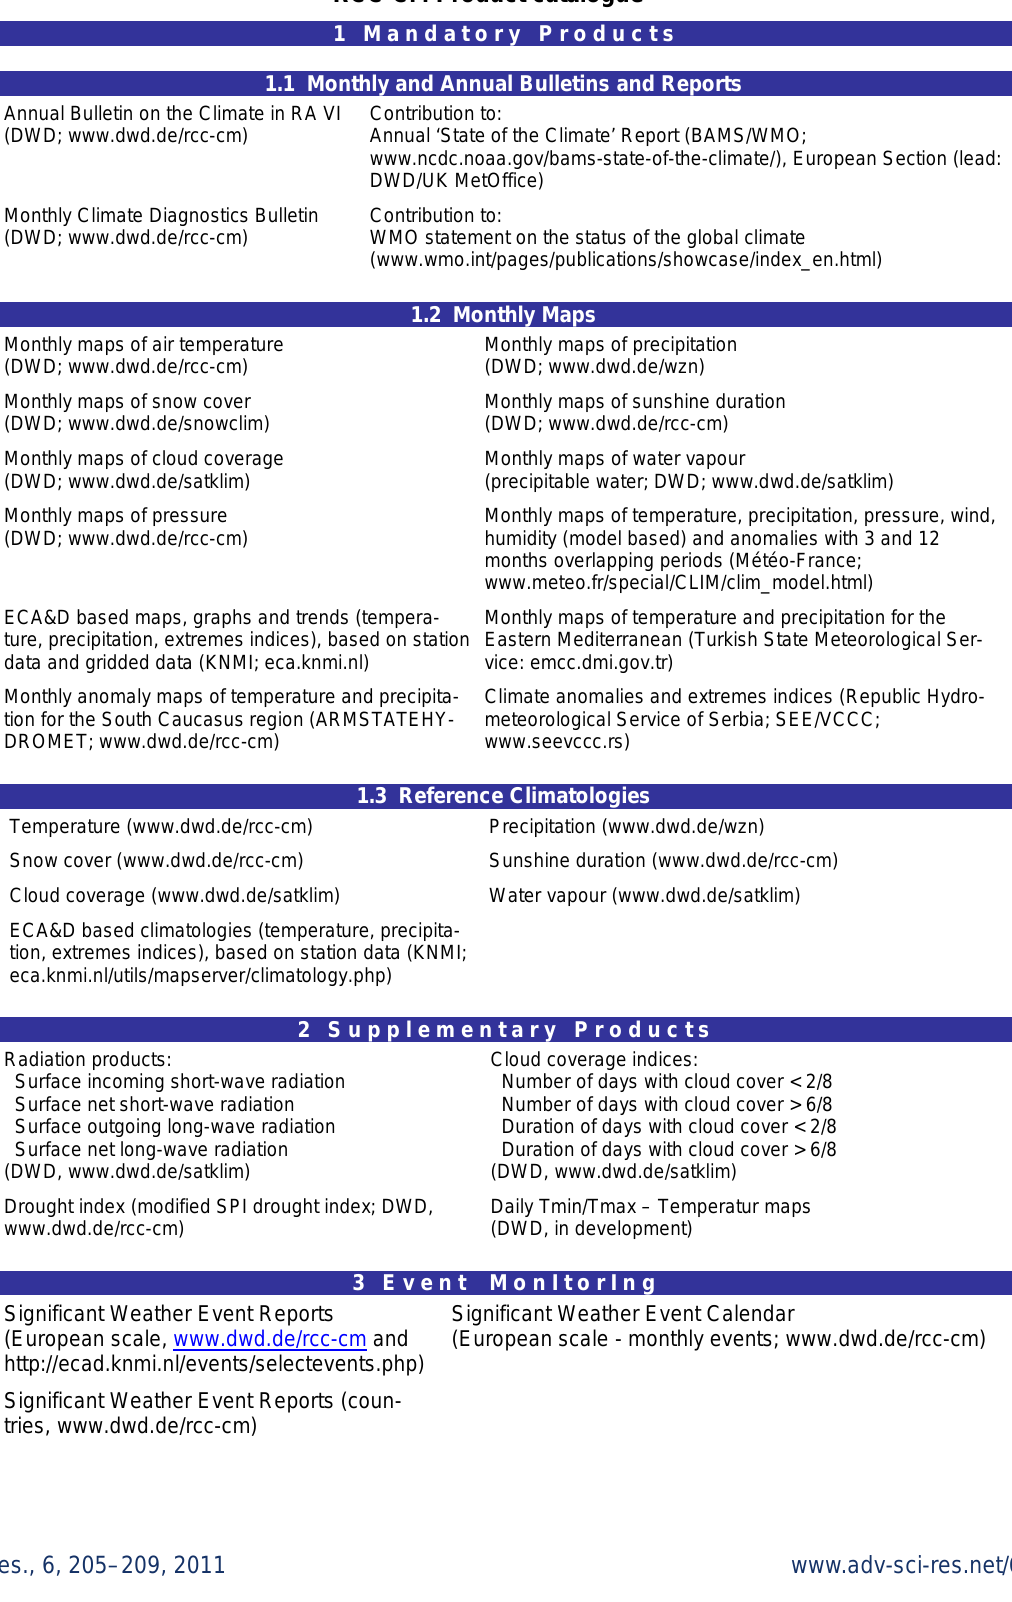
Table 1. RCC-CM Product catalogue, Status of 31 December 2010.